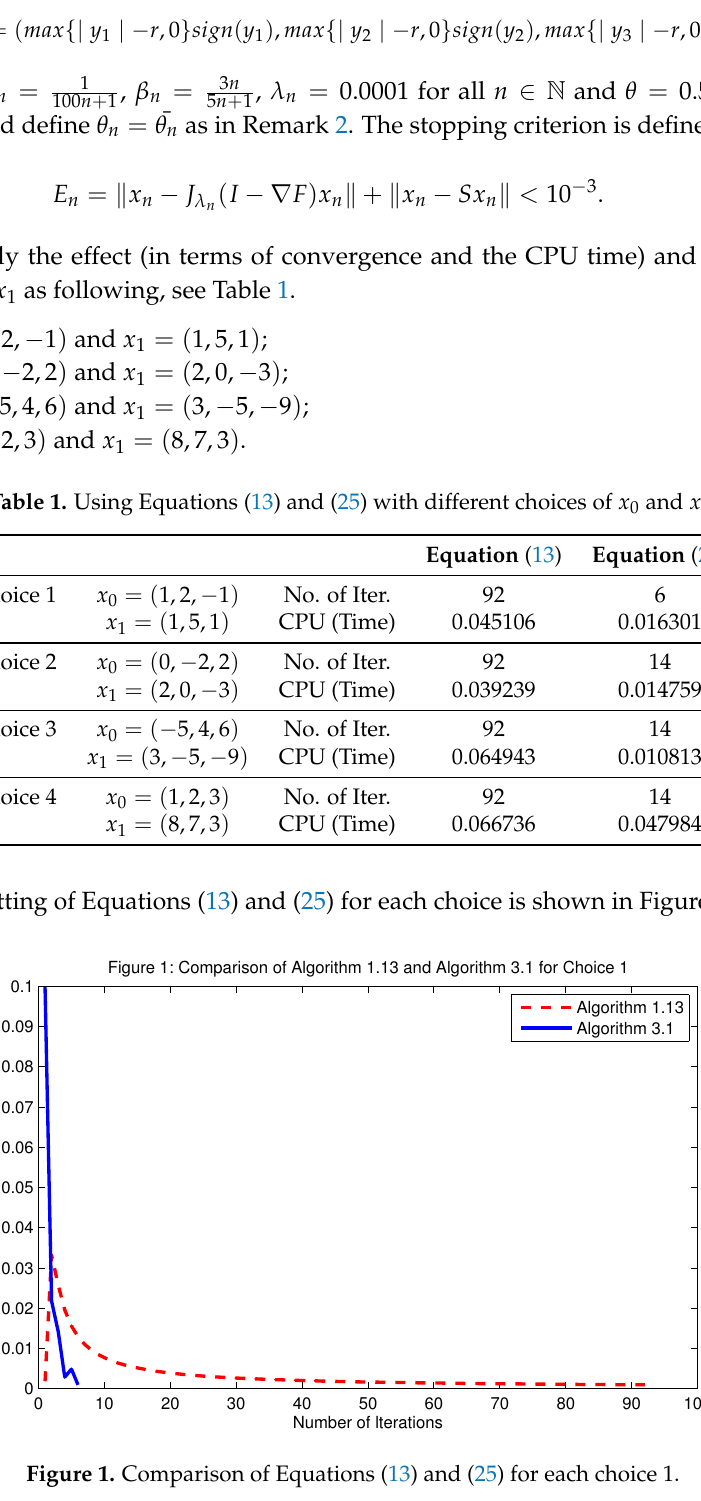
Figure 1. Comparison of Equations (13) and (25) for each choice